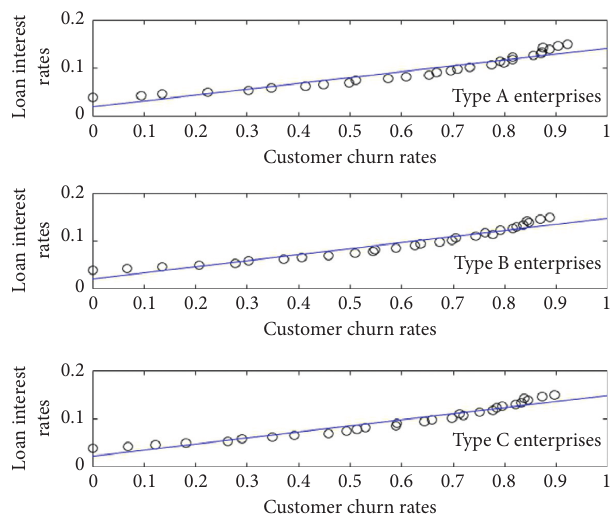
Figure 2: The relationship between loan interest rates and customer churn rates of three types of credit